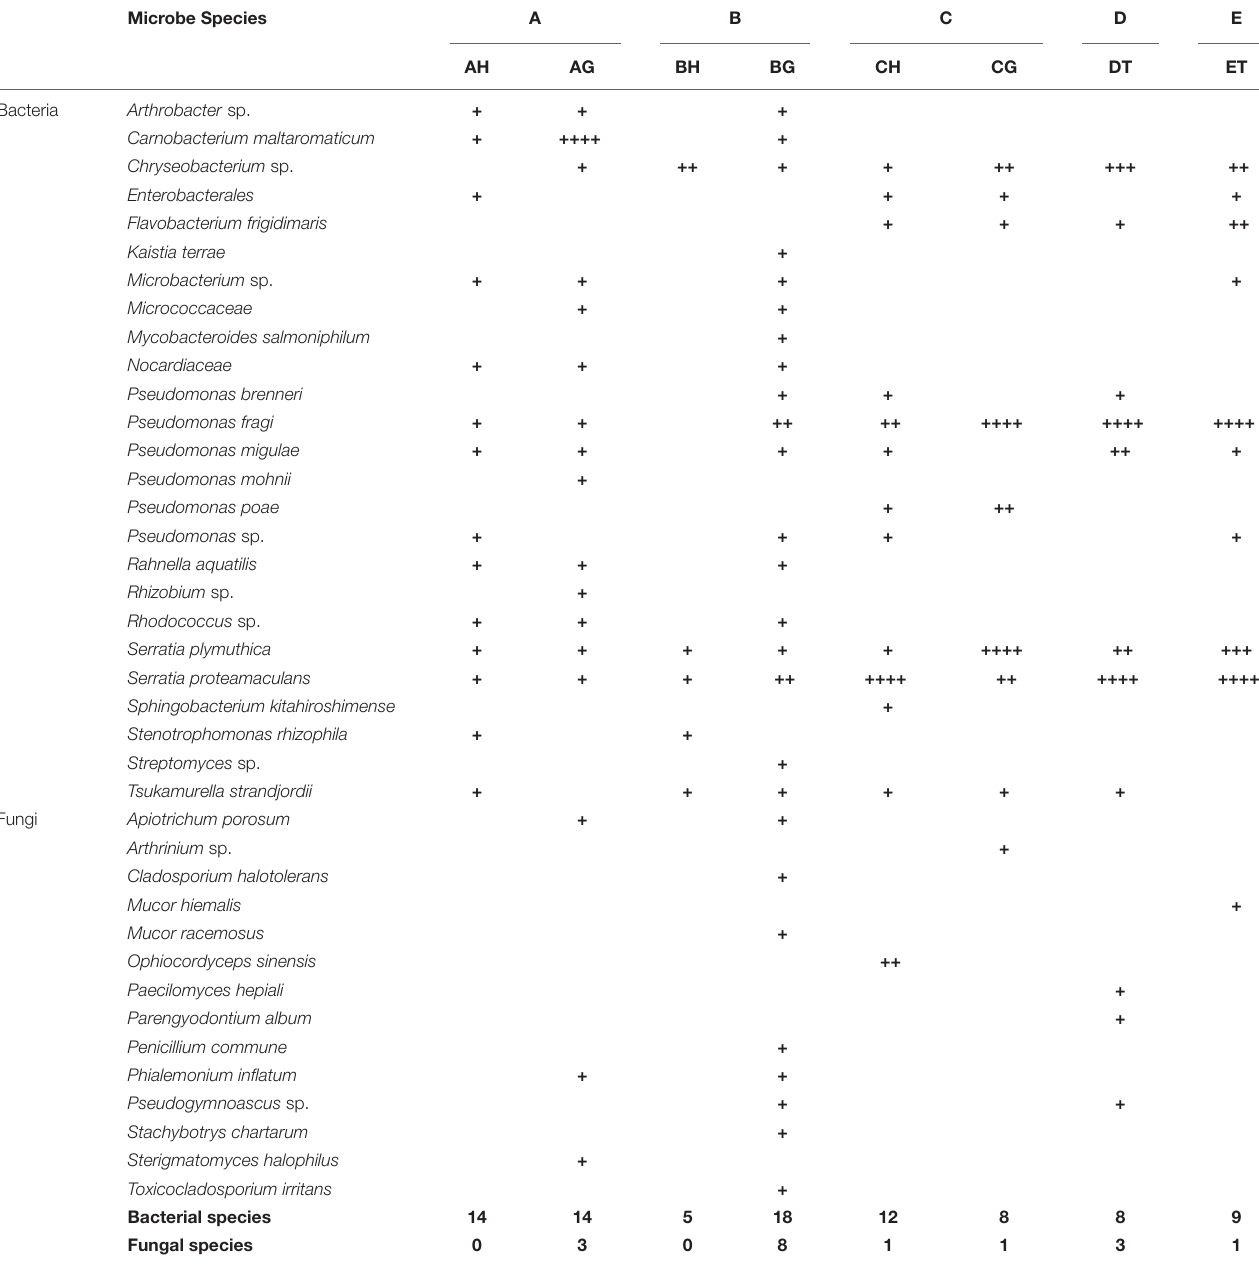
TABLE 1 | Bacterial and fungal species identified in the larval hemolymph, gut and tissue by culture-dependent